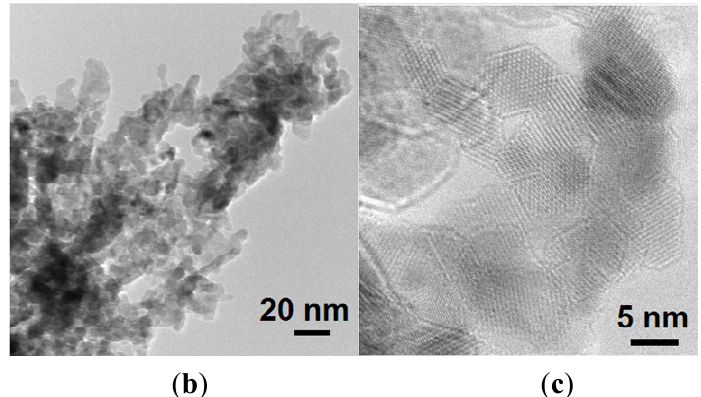
Figure 3. ( a ) a low magnification bright field TEM images of Co 3 O 4 nanostructures with an insert showing a selected area electron diffraction (SAED) pattern; ( b ) HRTEM image